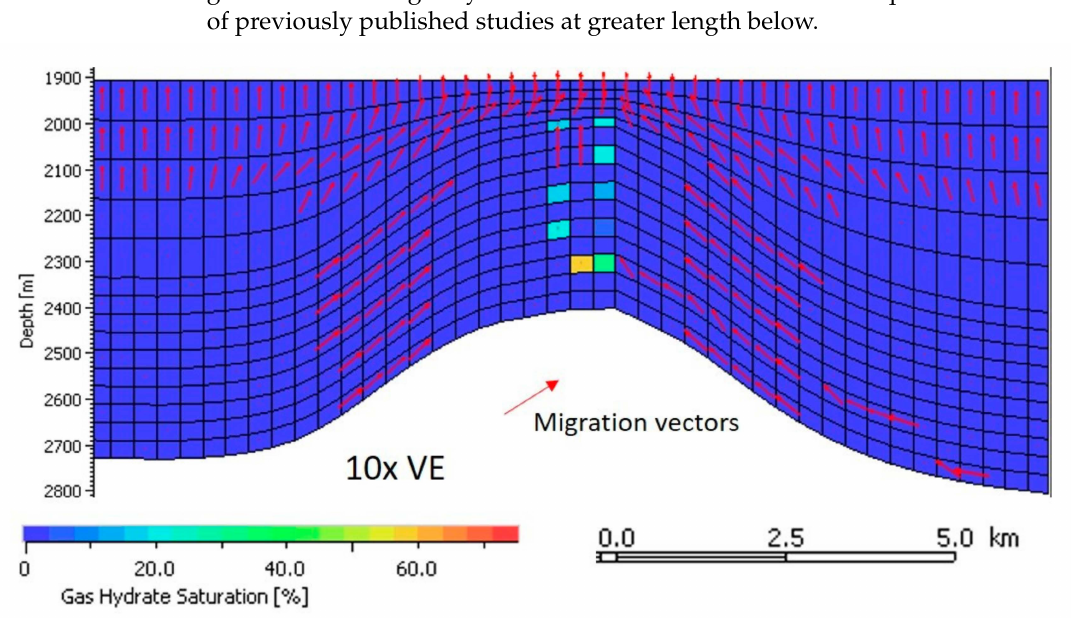
Figure 3. Two-dimensional cross-section view of modeled gas migration (red arrows) and gas hydrate formation (colored cells) under the 0.1 wt. % TOC, 100 HI scenario. Note 10 × vertical exaggeration.